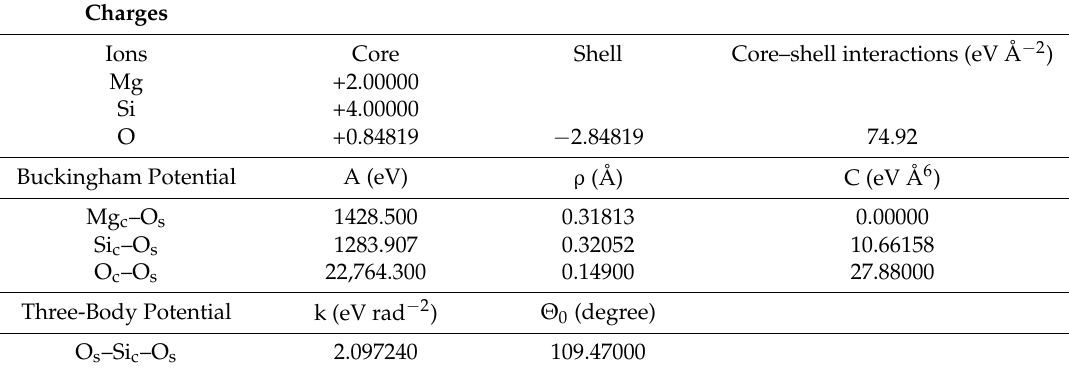
Table 1. Classical potential parameters used in this study. Sub-index c and s have been used to refer to the core and shell of the